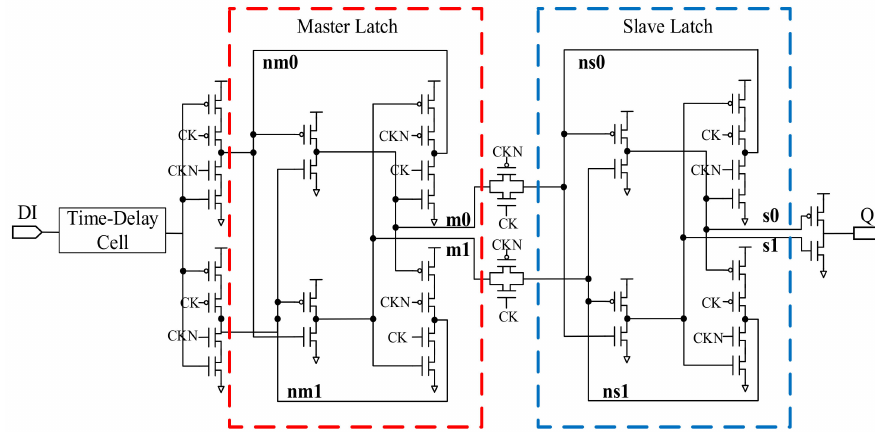
Figure 1. Basic structure of the DICE DFF.